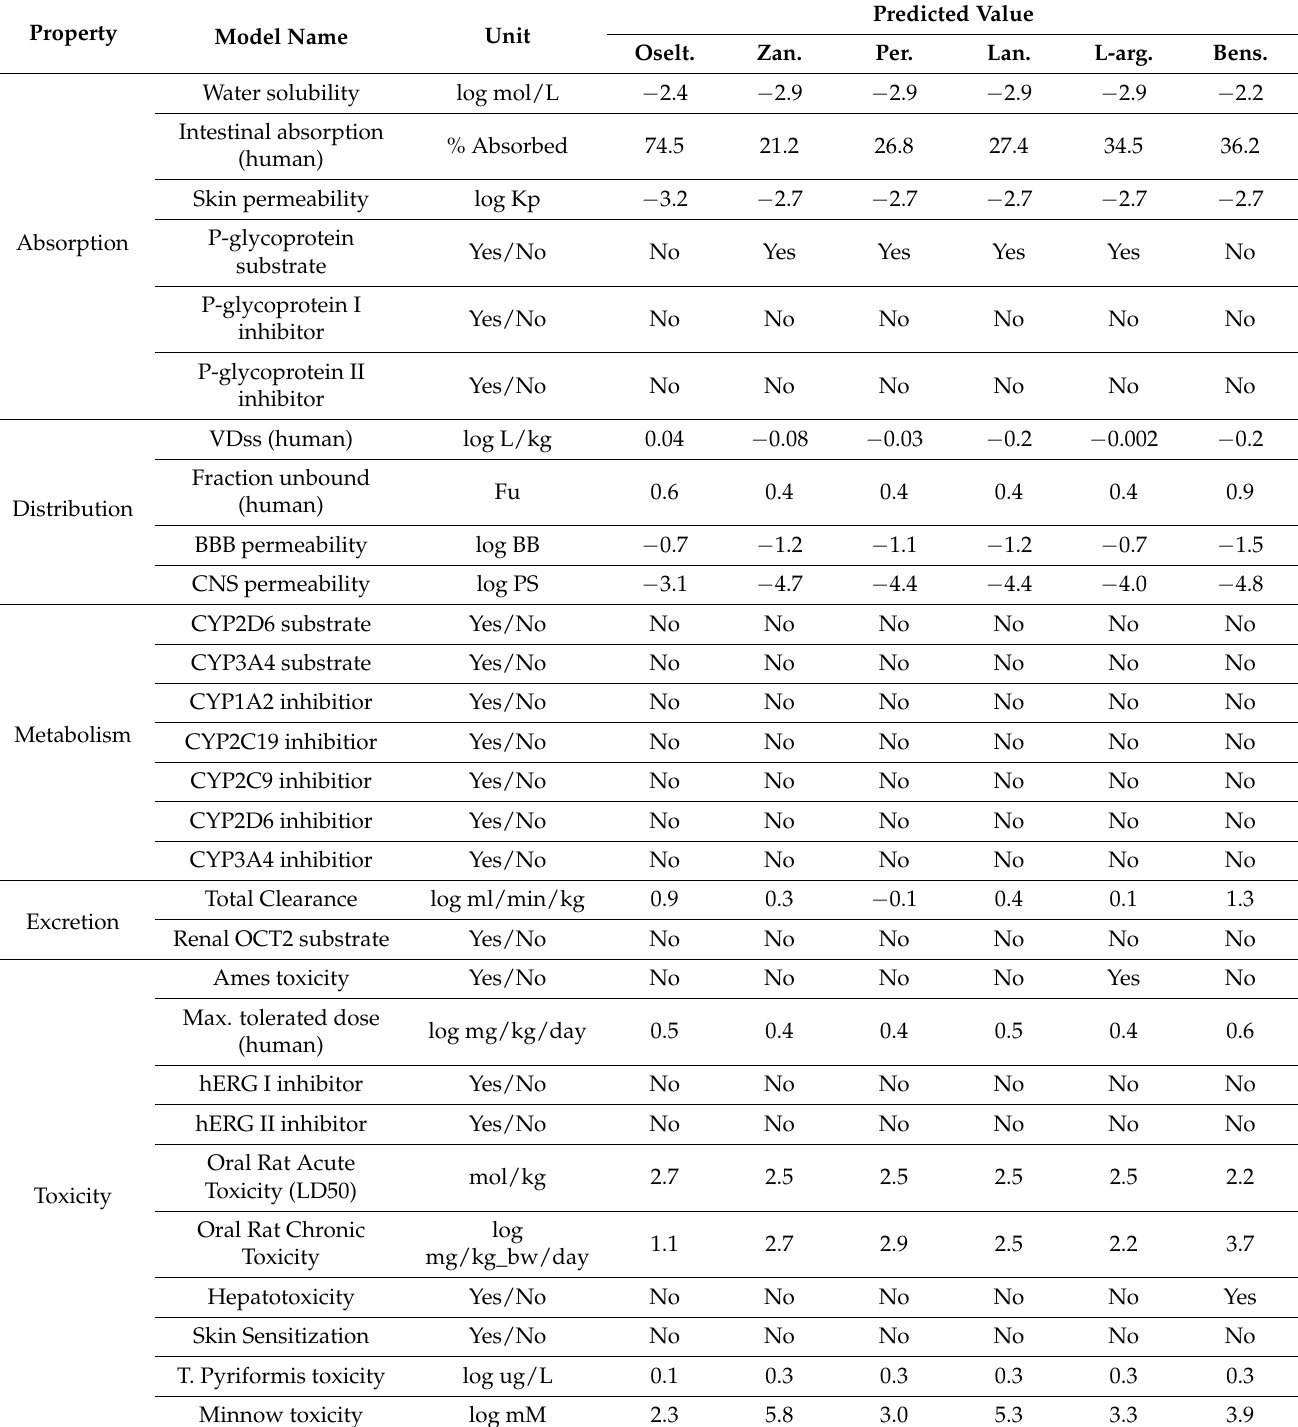
Table 7. Predicted ADMET properties for the drugs Oseltamivir, Zanamivir, Peramivir, Laninamivir, L-Arginine and Benserazide